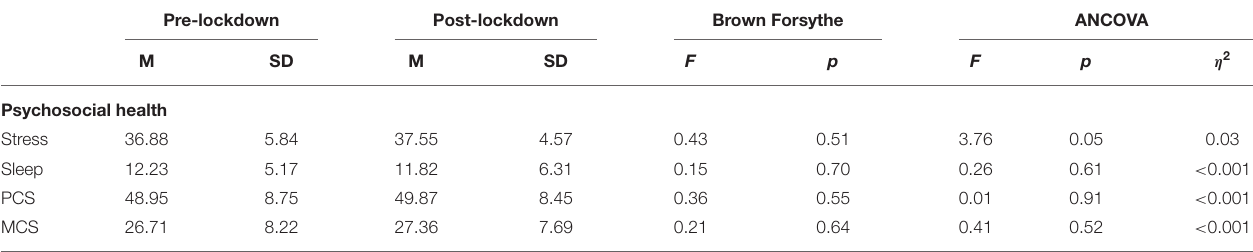
TABLE 2 | Between-group differences in psychosocial